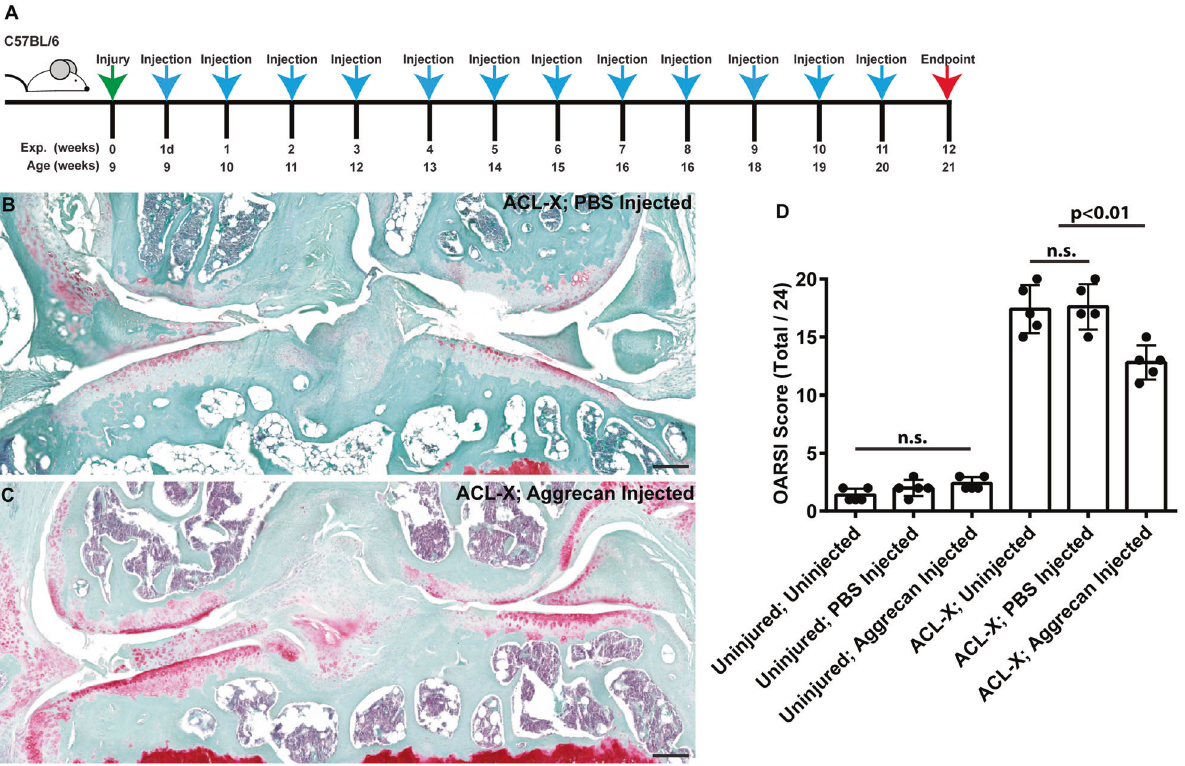
Fig. 8 Injection of aggrecan into mice post-ACL-X in chondro-protective. Mice with or without joint injury (ACL-X) were subjected to intraarticular injection ( A ). Mouse joints without ACL-X injury, but with injection of aggrecan show little difference vs. non-injected joints